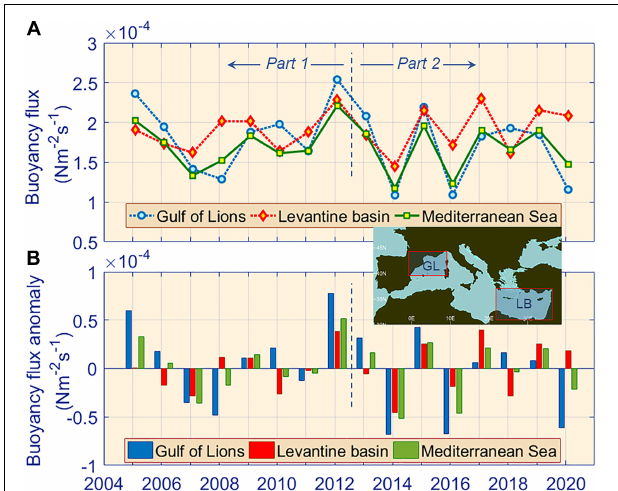
FIGURE 8 | (A) Time-averaged buoyancy flux B 0 during winter months (December, January and February) from 2004 to 2020 (sixteen data, starting in December 2004 and ending in February 2020). The fluxes have been spatially averaged for three regions, Gulf of Lions (GL in the inset map), Levantine basin (LB in the map) and the whole MedSea, as indicated in the legend. (B) Buoyancy flux anomaly of the data showed in panel (A) referred to the 2004-2020 mean. Vertical dashed line separates parts 1 and